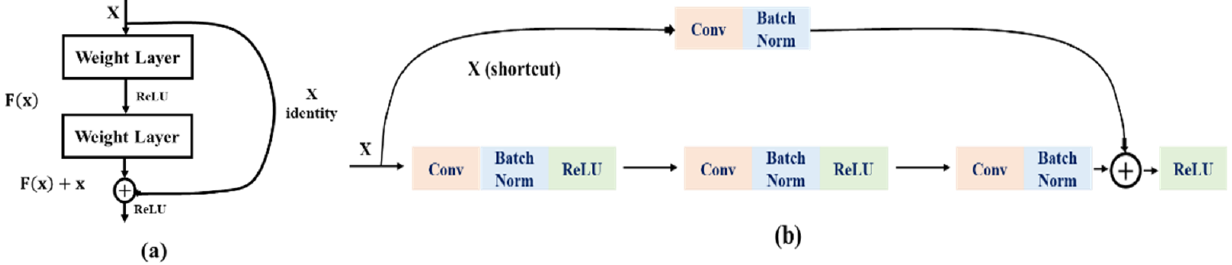
Figure 2. Residual module: ( a ) residual module operation process; ( b ) shortcut connection.